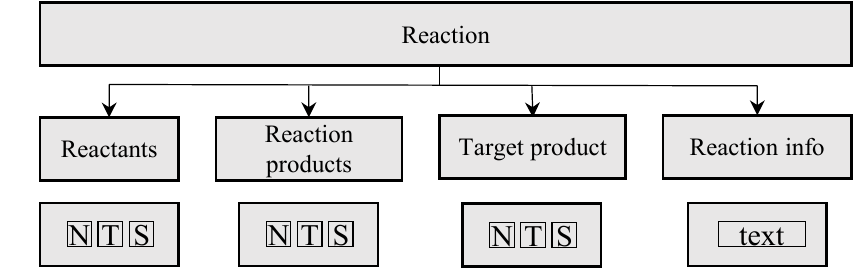
Figure 3. Sub-classes and instance/individuals for the reaction class of the database.